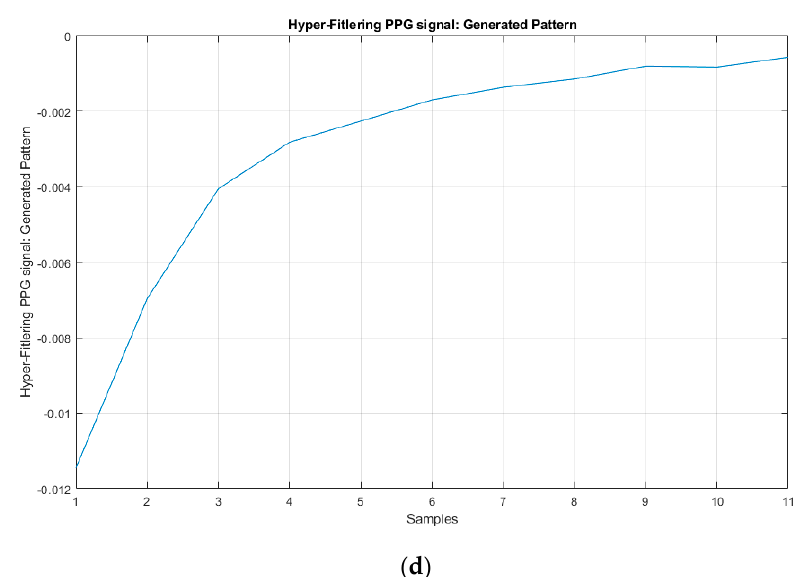
Figure 10. Instances of the generated signal-patterns: ( a ), ( b ) 𝛇 𝐇𝐏𝐤 (𝐬(𝐭 𝐤 )) ; ( c ), ( d ) 𝛇 𝐋𝐏𝐤 (𝐬(𝐭 𝐤 )) .